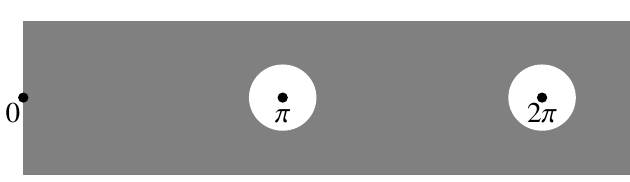
Figure 1. A typical domain of the form S